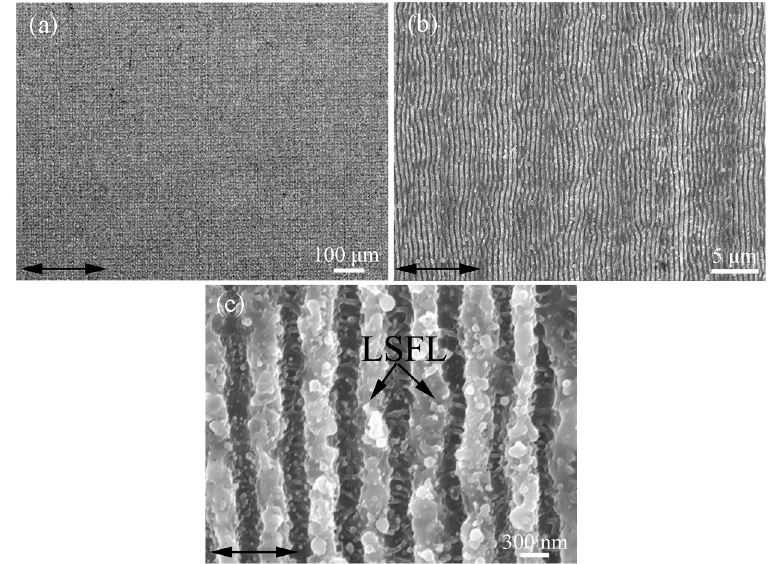
Figure 2. SEM (scanning electron microscope) micrographs of the LIPSS (laser-induced periodic surface structures) on the AISI (American Iron and Steel Institute) 304L steel surfaces. Note the different magnifications used in ( a )–( c ). The black double-headed arrow indicates the polarization direction of the femtosecond laser pulses.